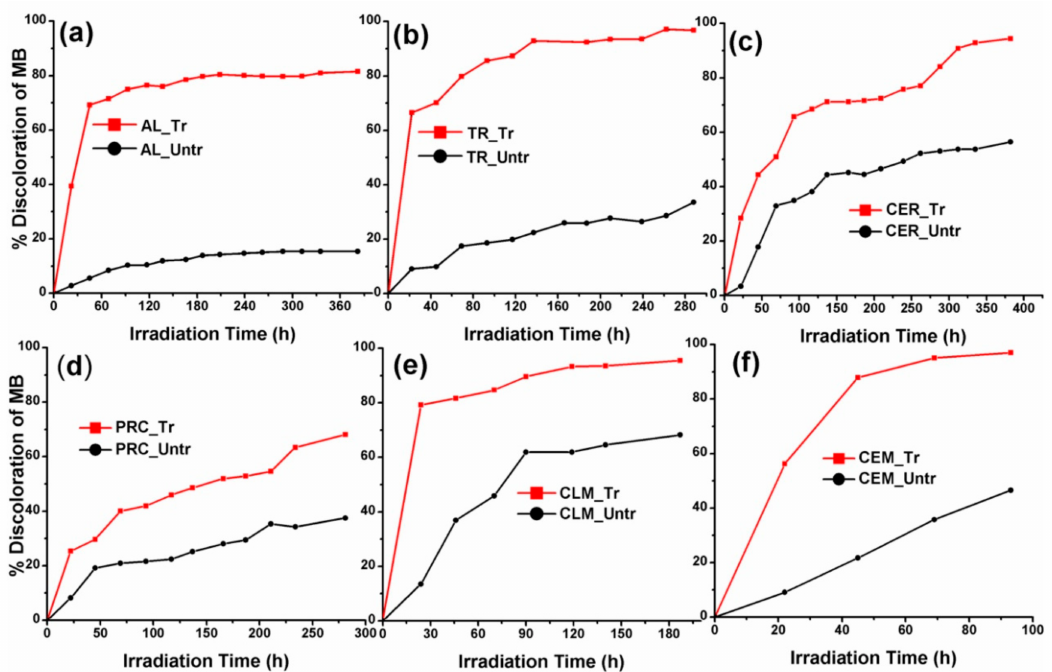
Figure 8. Assessment of the self-cleaning efficiency of the SP&T: ( a ) AL; ( b ) Tr; ( c ) CER; ( d ) PRC; ( e ) CLM and ( f ) CEM treated